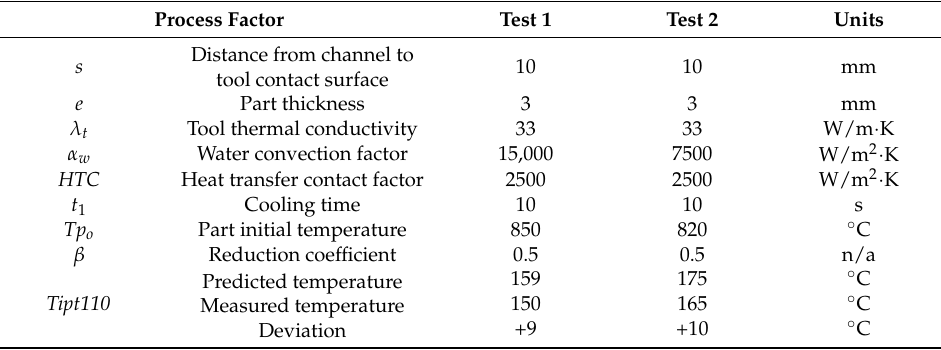
Figure 14. Test curves for verifying the model accuracy. Table 6. Experimental checking of the accuracy characterizing the simplified polynomial for predicting Tipt110